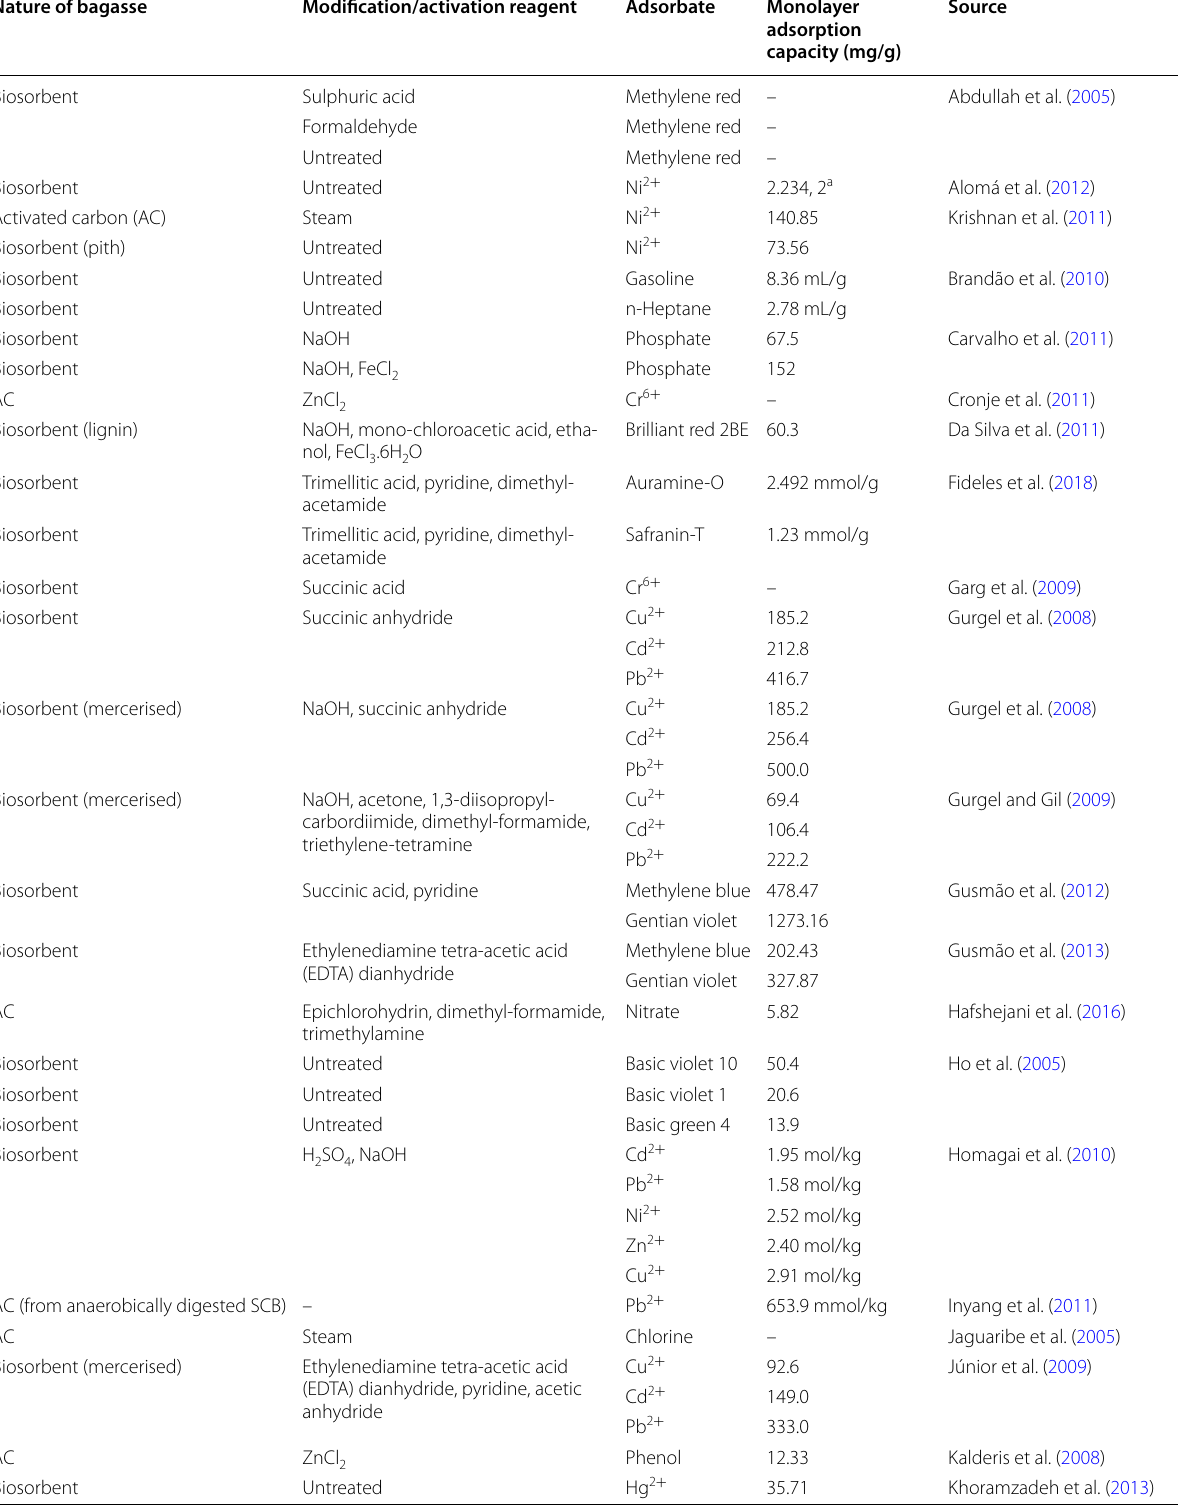
Table 10 Summary of SCB application as adsorbents Nature of